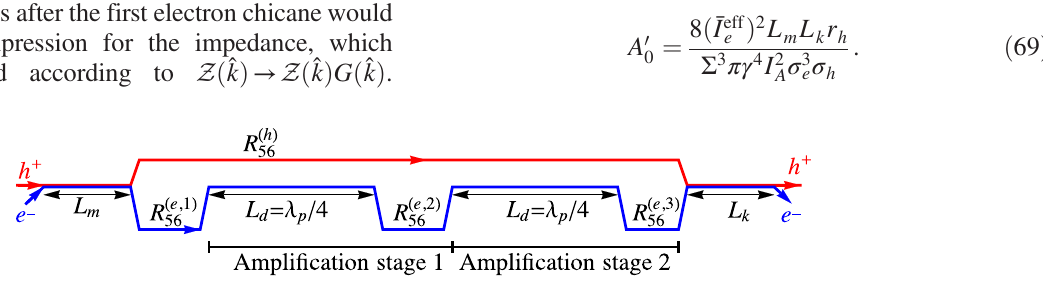
FIG. 5. An MBEC configuration with two plasma amplification